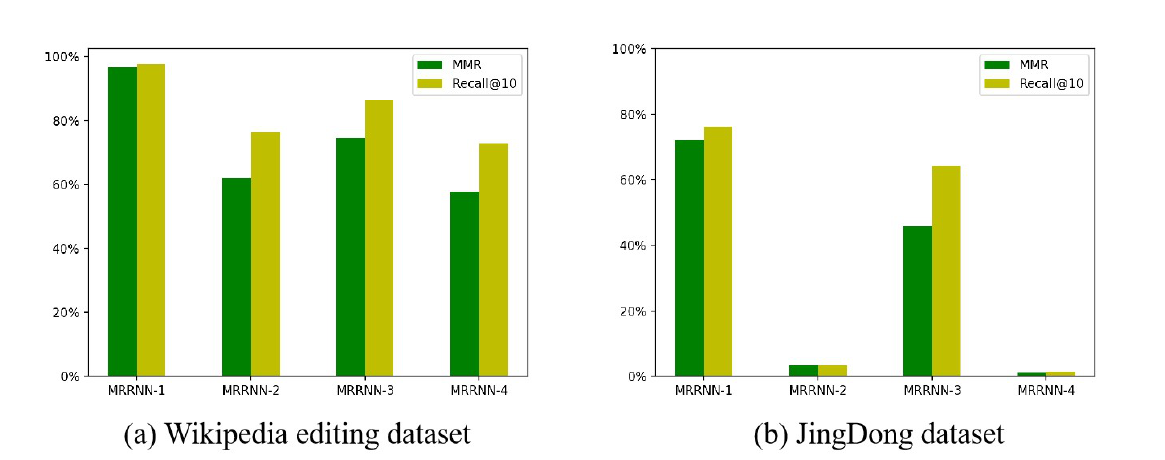
Figure 6. The percentage of each variant’s performance to the performance of the full model on the two datasets.